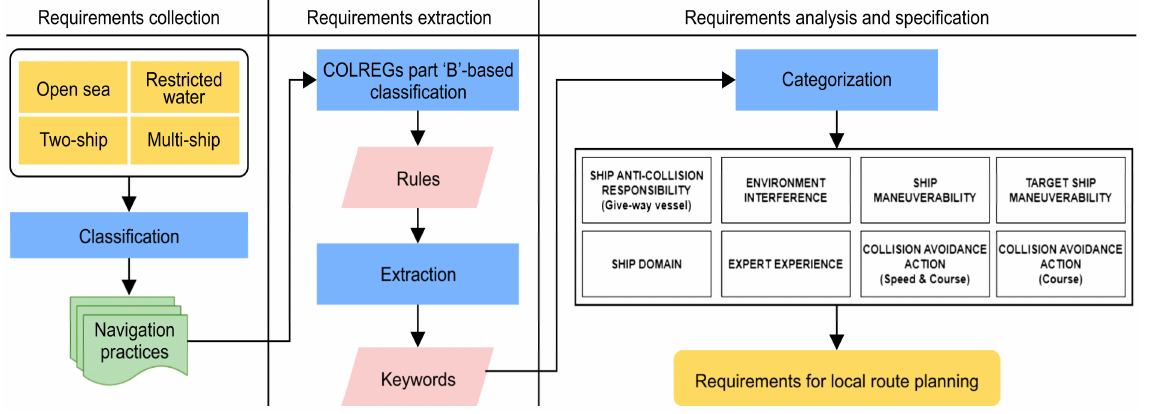
Figure 1. Process of requirements